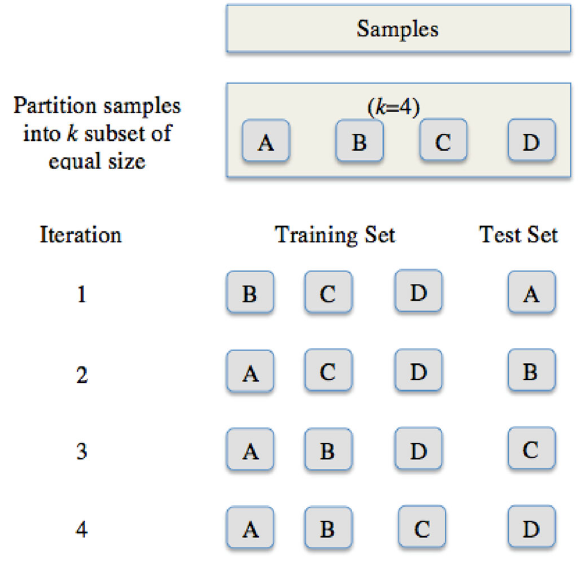
Figure 4. Example of stratified fourfold cross ‐ validation.